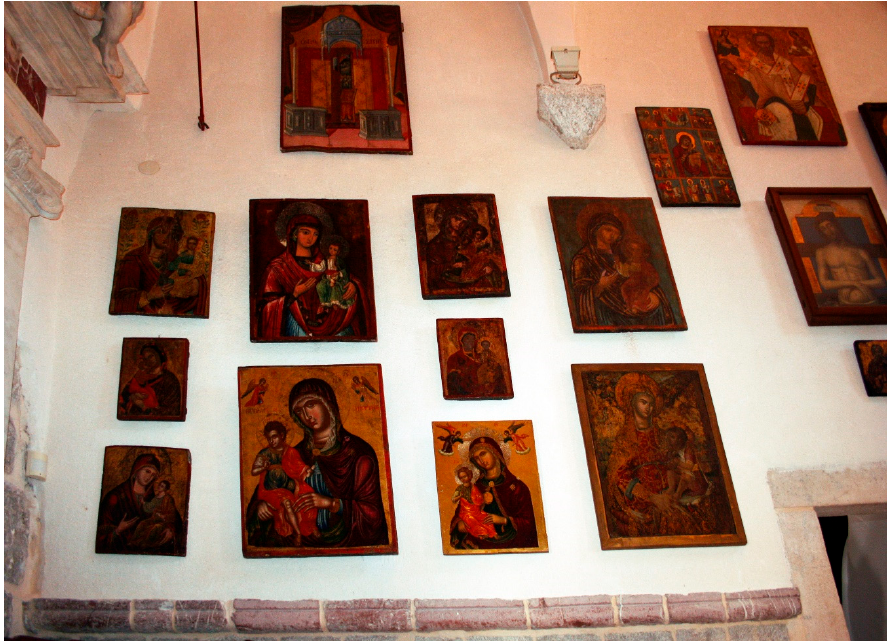
Figure 14. Icons from private collections and churches of the Boka Kotorska , Kotor, Cathedral of Saint Tryphon (Katedrala Svetog Tripuna) (photograph by the